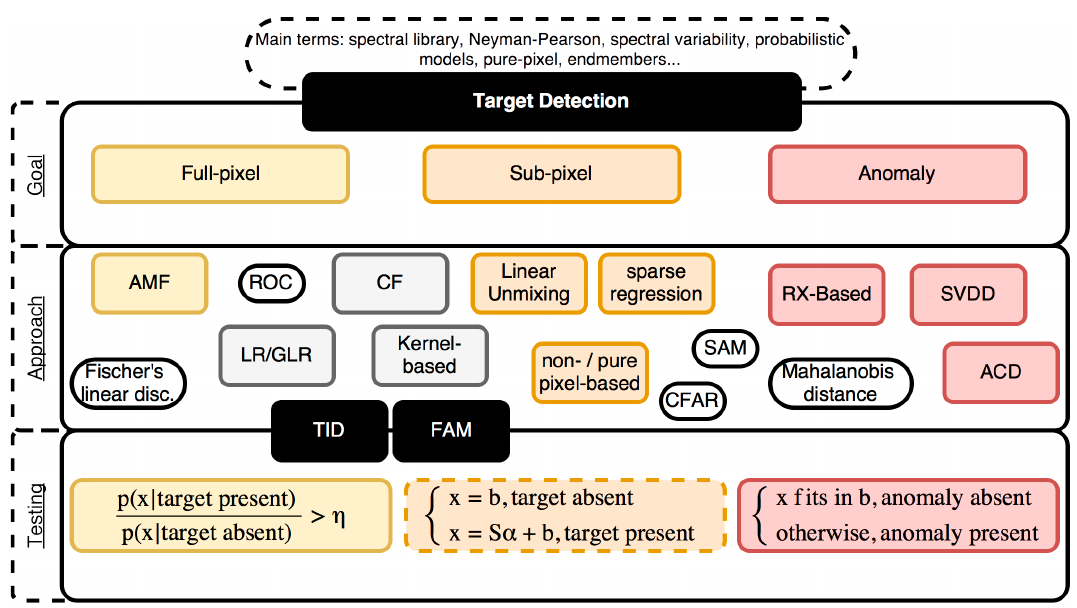
Figure 6 . Target detection overall summary organized by goal, approach and testing hypothesis. Terms association is made through color code. Grey and white labels are related to more than one goal. For full-pixel detection, an adaptive matched filter (AMF), continuum fusion and kernel-based algorithms can be applied. Linear unmixing, sparse regression and non-/pure pixel-based approaches regard to sub-pixel detection (mixed material spectra cases). Anomaly detection, which is used to recognize patterns standing out from cluttered backgrounds, can be addressed with approaches based on Reed-Xiaoli (RX), support vector data description (SVDD) and anomalous change detection (ACD). Grey and white labels constitute the taxonomy for supporting statistical tools. Spectral angle mapper (SAM), Mahalanobis distance and likelihood ratio (LR) aims to test if a pixel is a target or not, considering a threshold to discriminate spectra of interest from background. Such threshold should consider a trade-off between false alarm and probability detection (towards Neyman-Person criterion satisfaction), which can be analyzed through receiving operator characteristic (ROC) curves. Common occurrences of probability densities relying in unknown targets and backgrounds demand a generalized likelihood ratio (GLR) workaround—the basis of adaptive detectors—consisting in replacing unknown parameters by maximum likelihood estimates. Constant false alarm rate (CFAR) promotes setting up detectors immune to background variations and noise. False alarm mitigation (FAM) and target identification (TID) are self-explanatory concepts regarding to recent developments in algorithms.